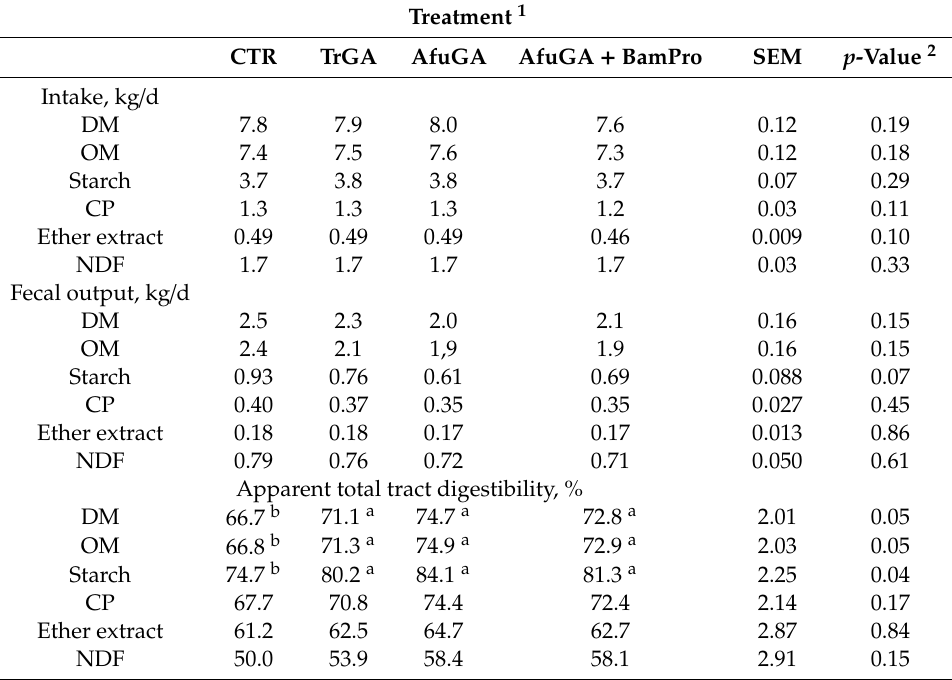
Table 2. Daily nutrient intake, nutrient fecal output and apparent total tract digestibility in crossbred Angus bulls fed TMR supplemented with the di ff erent enzymes (TrGA = Trichoderma reesei glucoamylase; AfuGA = Aspergillus fumigatus glucoamylase; AfuGABamPro = Aspergillus fumigatus Glucoamylase + Bacillus amyloliquefaciens neutral